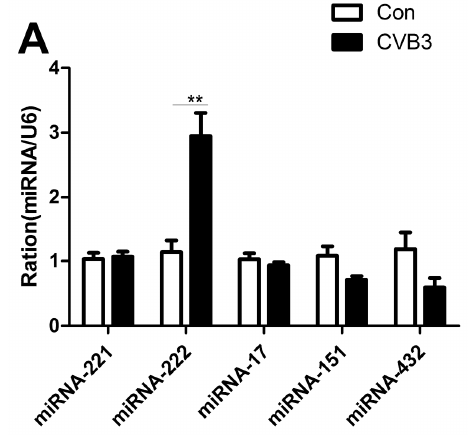
Figure 4. Cont. Figure 4. Cont